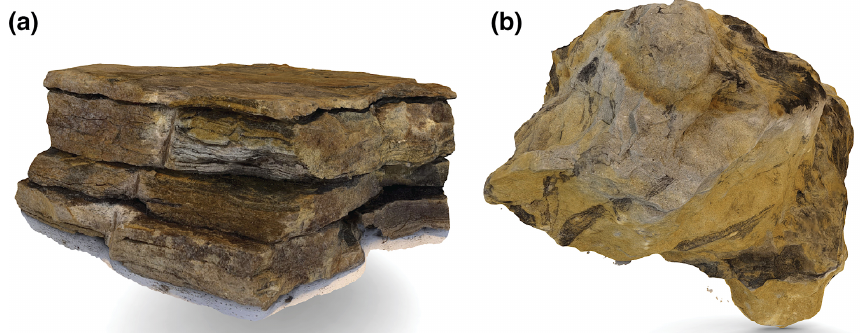
Figure 4. 3D virtual models of hand samples from the American Vitrified 2 outcrop: (a) AV 2-1 mudstone from the base of the outcrop (arrow in Fig. 3), maximum diameter of sample 13cm; (b) AV 2-2 sandstone with Stigmaria from the outcrop model annotation 2 (in Fig. 2), maximum diameter of sample 15cm. These samples are available as models AV 2-1 and AV 2-2 via Sketchfab; scale bars are provided separately in still photos of these hand samples hosted for students on the project